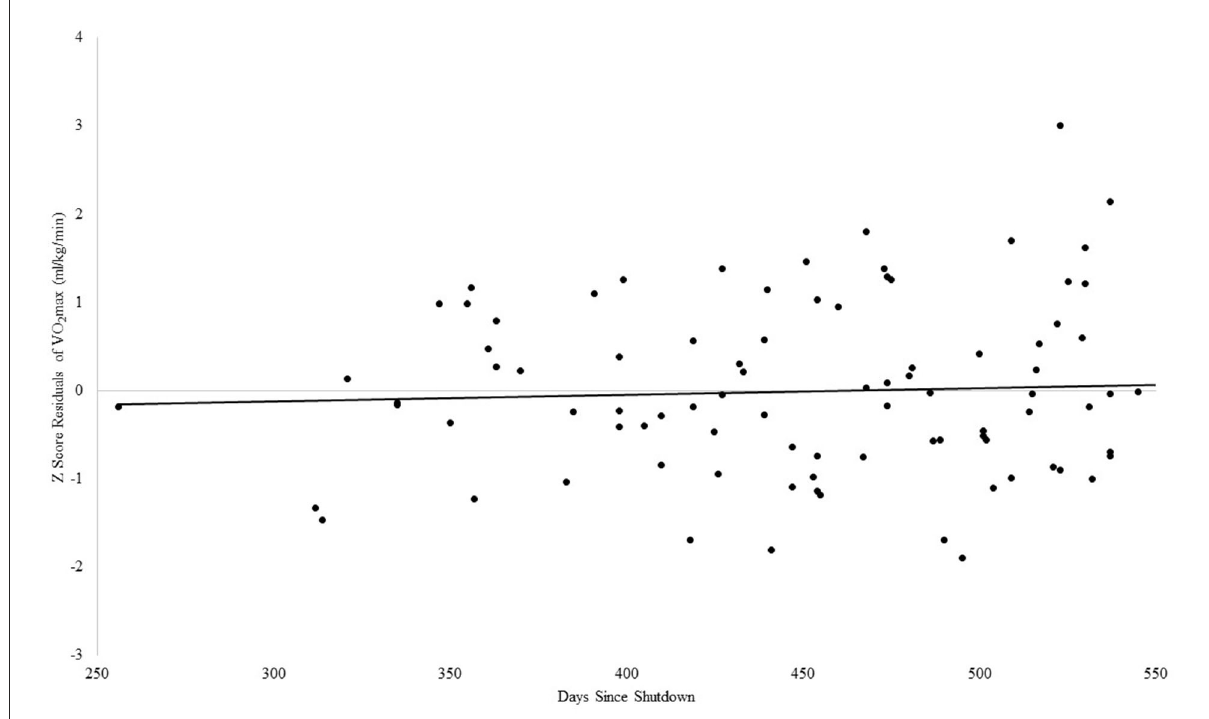
FIGURE3 Association between days since COVID-19 shutdown and VO 2 max in older adults